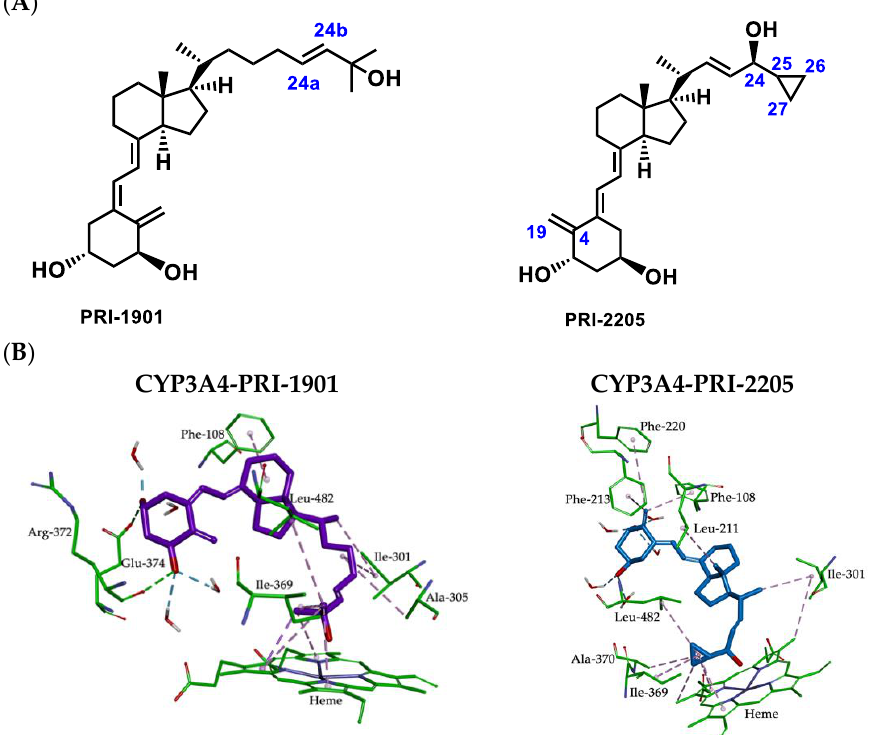
Figure 9. ( A ) Structural formulas of the analogs of 1 α ,25-dihydroxyvitamin D 3 (PRI-1901 and PRI-2205). ( B ) Molecular interactions between 1,25D3 analogs (PRI-1901 and PRI-2205) and CYP3A4 resulting from MD simulations. Hydrophobic interactions are shown as magenta dashed lines and hydrogen bonds as green.